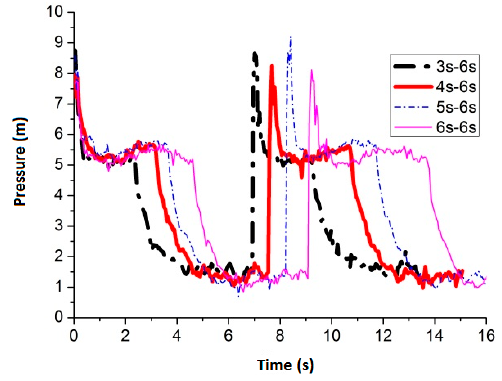
Figure 4. The four best pressure values (round nozzle in the middle of the pipe).